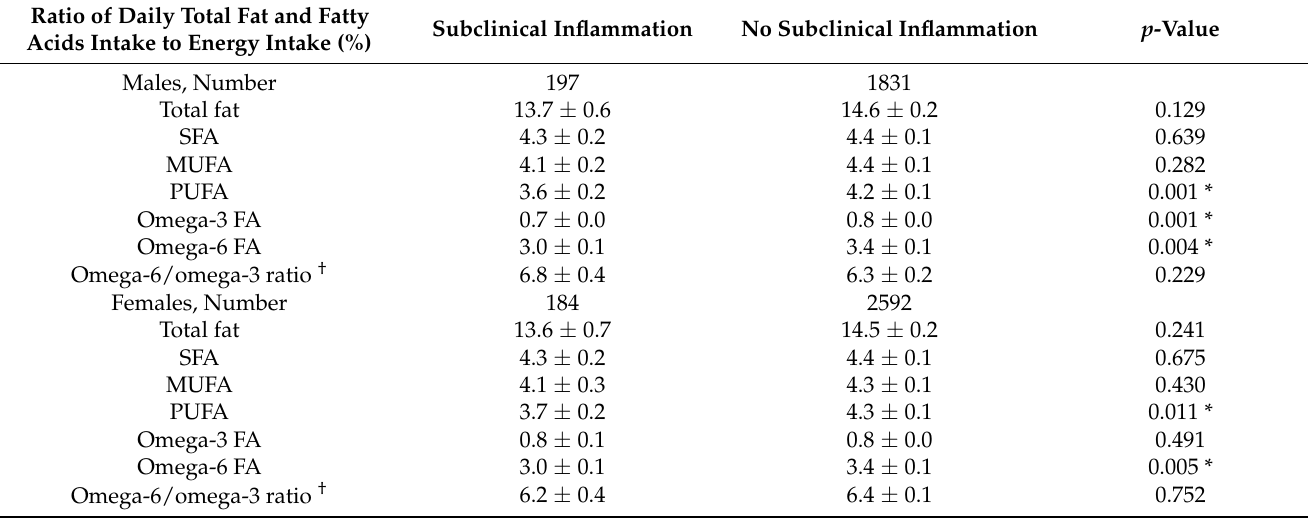
Table 3 presents fat intake according to the presence of subclinical inflammation. In males, the ω 3FA ratio in subjects without subclinical inflammation was significantly higher than that in subjects with subclinical inflammation (0.8% in subjects with no subclinical inflammation vs. 0.7% in subjects with subclinical inflammation, p -value = 0.001). However, ω 3FA ratio in females was not significantly different between the two groups with and without subclinical inflammation ( p -value = 0.491). Omega-6/omega-3 ratios were not significantly different in both sexes (all p -values > 0.05). Table 3. Ratio of daily total fat and fatty acids intake to energy intake according to the presence of subclinical inflammation. Ratio of Daily Total Fat and Fatty Acids Intake to Energy Intake